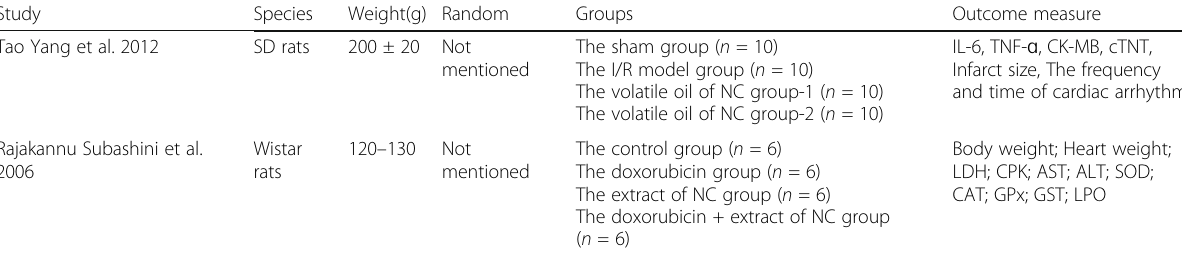
Table 1 The detailed information of the animal